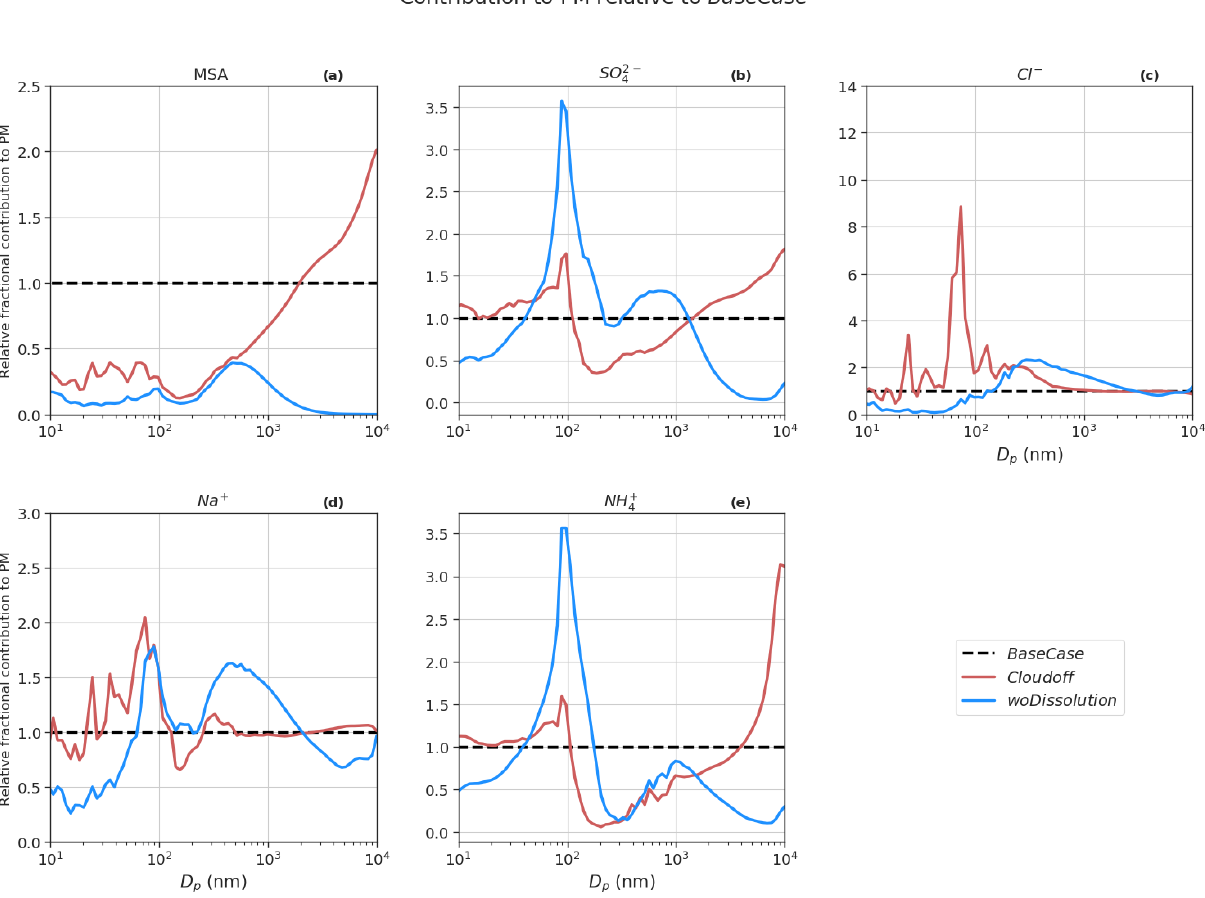
− (b) , Cl − (c) , Na + (d) , and NH + 4